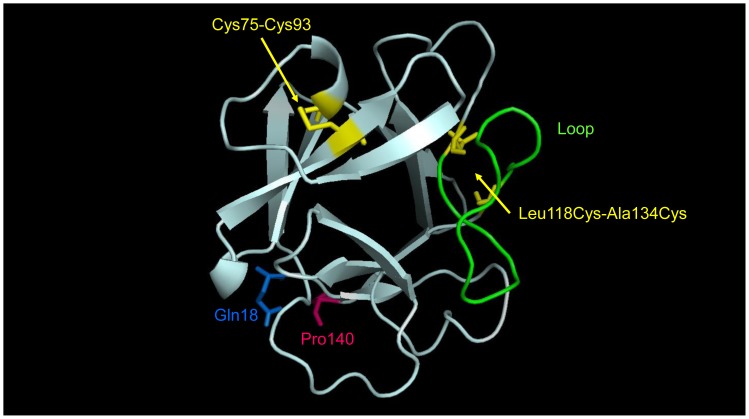
FGF21 homology model.An engineered disulfide bond in LY2405319 achieved loop stabilization at the C-terminus. The FGF21 homology model includes residues 18–140 of the human sequence. The native disulfide at C75-C93 and the new engineered disulfide bond at Leu118Cys-Ala134Cys are highlighted in yellow. The intervening loop between Leu118Cys and Ala134Cys is highlighted in green.